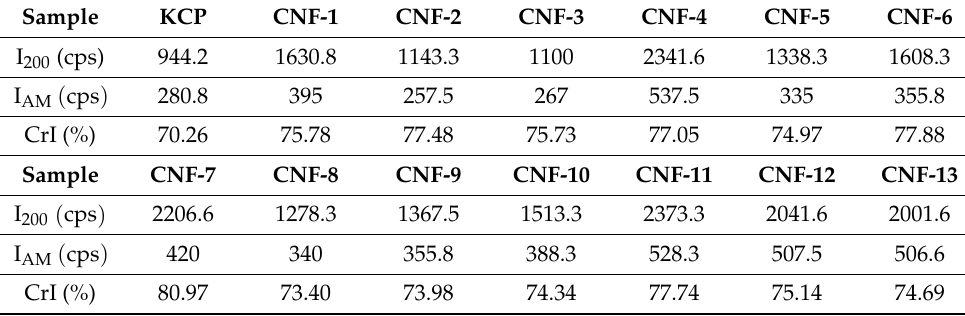
Figure 2. Contour plot of glucose concentration (g/L) as a function of enzyme loading (U/g). The values shown in the legend correspond to the glucose concentration (g/L). Table 1. Crystallinity index of KCP and CNF samples from